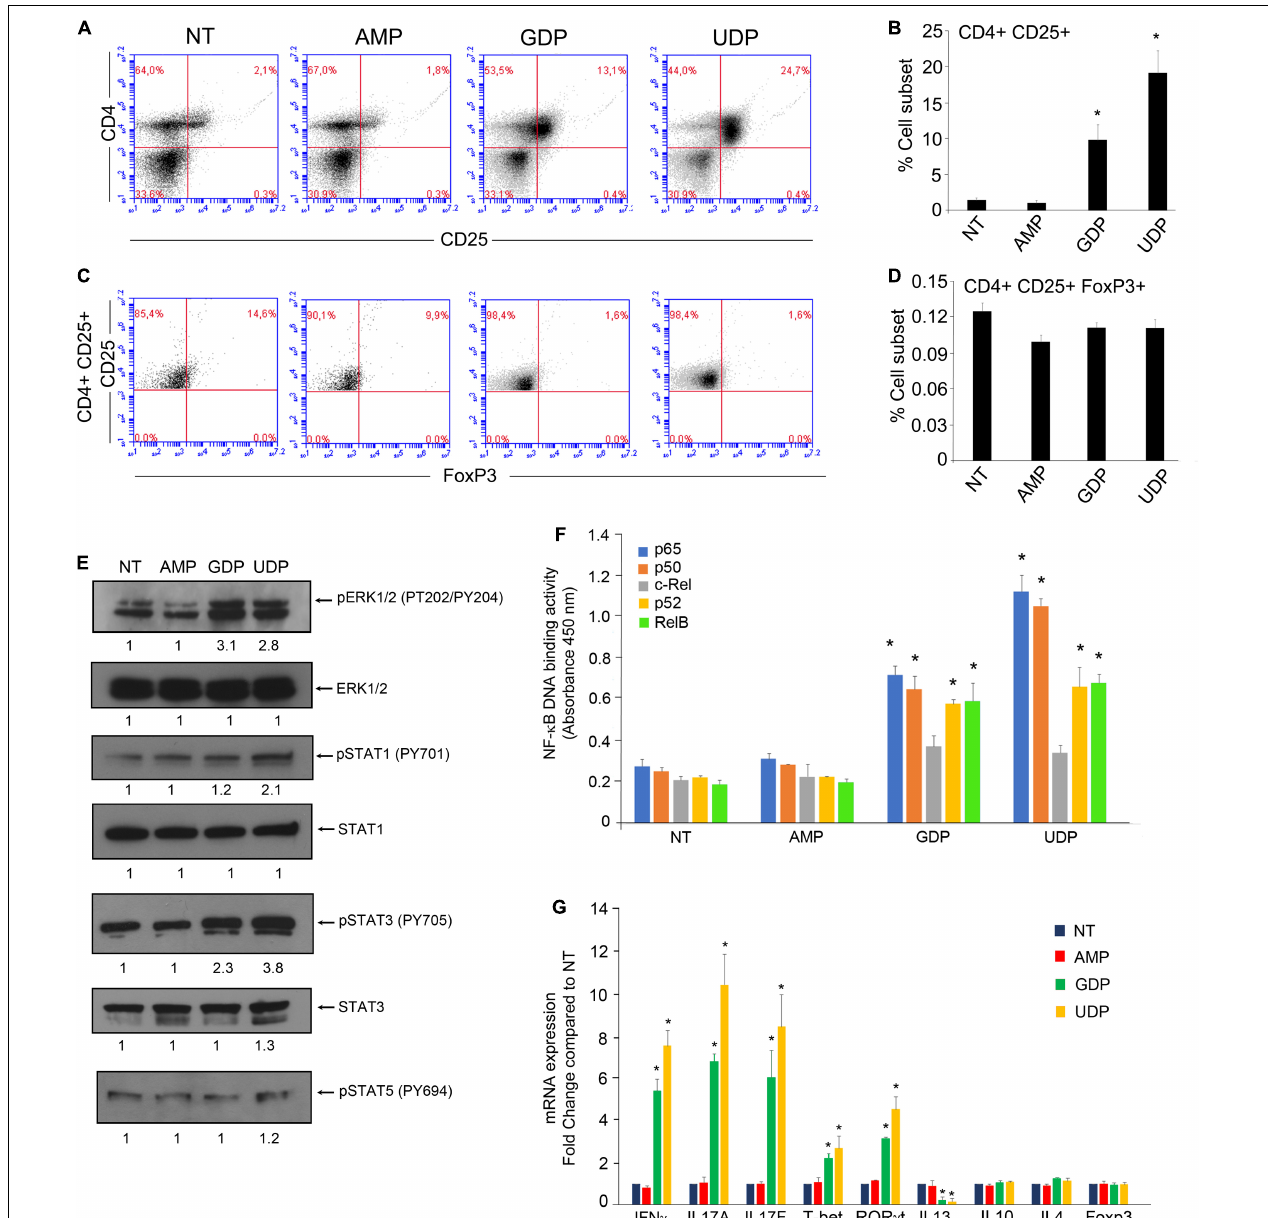
FIGURE 2 | GDP and UDP modulate immune response of CD4 + T-cells. (A) PBMCs (1 × 10 6 ) were treated with 30 µ M of indicated metabolites for 24 h and were stained with CD4-FITC and CD25-PE. Each plot represents 20,000 events of a representative experiment. (B) Percentage of CD4 + CD25 + population in the different conditions. Values (mean ± SE, n = 6) are shown. The asterisk indicates a statistically significant difference compared to untreated control, according to Student’s t -test ( p < 0.01). (C) PBMCs stained with CD4-FITC and CD25-PE were permeabilized and next stained with FoxP3-APC. Each plot represents 20,000 events of a representative experiment. (D) Percentage of CD4 + CD25 + FoxP3 + population in the different conditions. Values (mean ± SE, n = 6) are shown. The asterisk indicates a statistically significant difference compared to untreated control, according to Student’s t -test ( p < 0.01). (E) CD4 + T-cells, isolated from PBMCs of healthy donors (5 × 10 6 ), were treated with 30 µ M of indicated metabolites for 2 h and then were lysed. Total protein extracts (30 µ g) were separated by 4–12% gradient NuPAGE and analyzed by Western blotting with anti-pERK1/2 (phospho-tyrosine 202/204), anti-ERK1/2, anti-pSTAT1 (phospho-tyrosine 701), anti-STAT1, anti-pSTAT3 (phospho-tyrosine 705), anti-STAT3, and anti-pSTAT5 (phospho-tyrosine 694). (F) CD4 + T-cells, isolated from PBMCs of healthy donors (5 × 10 6 ), were treated with 30 µ M of indicated metabolites for 2 h, and then nuclear extracts were collected. Nuclear extracts (10 µ g) were analyzed for the p65, p50, c-Rel, and RelB binding to the NF- κ B double-stranded oligonucleotide using the NF- κ B Transcription Factor ELISA Assay kit (Cayman). Values are the mean ± SD of three independent experiments. The asterisk indicates a statistically significant difference compared to untreated control, according to Student’s t -test ( p < 0.01). (G) PBMCs of healthy donors (5 × 10 6 ) were treated with 30 µ M of indicated metabolites for 12 h, and then CD4 + T-cells were isolated by using CD4 + T-cells isolation kit (Miltenyi Biotec). Total RNA was extracted and analyzed by RT-qPCR to evaluate the mRNA expression of the indicated genes. Values are the mean ± SD of three independent experiments. The asterisk indicates a statistically significant difference compared to untreated control, according to Student’s t -test ( p < 0.01).